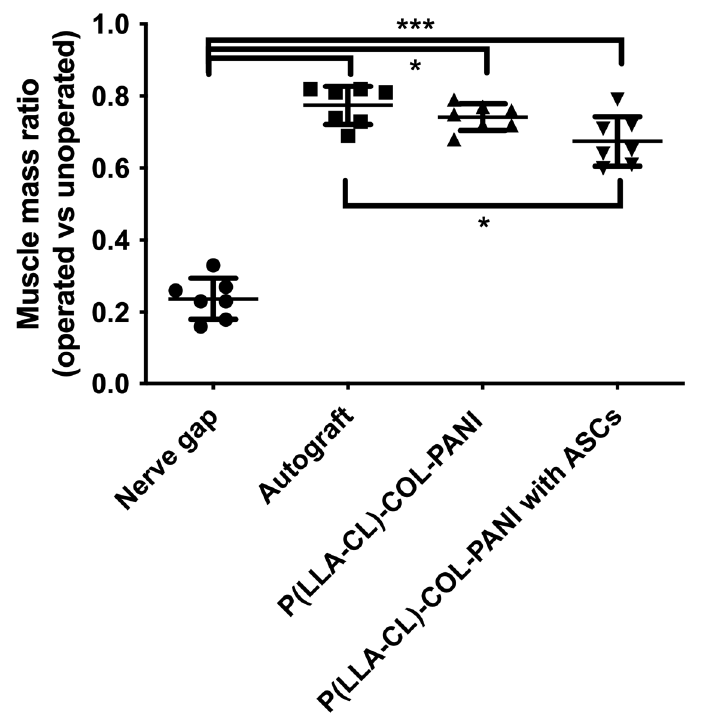
Figure 7. Diagram represents muscle mass ratio (operated vs. unoperated limb) among examined groups. Mean ± SD, * p < 0.05, **** p < 0.0001.